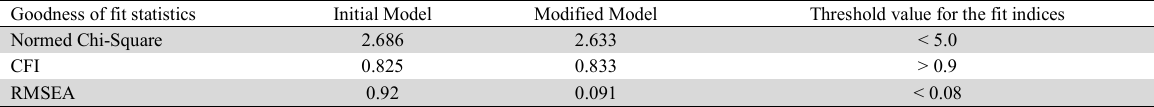
Fig. 2. Confirmatory factor analysis (CFA) of overall Measurement Model CFA results for Overall Measurement